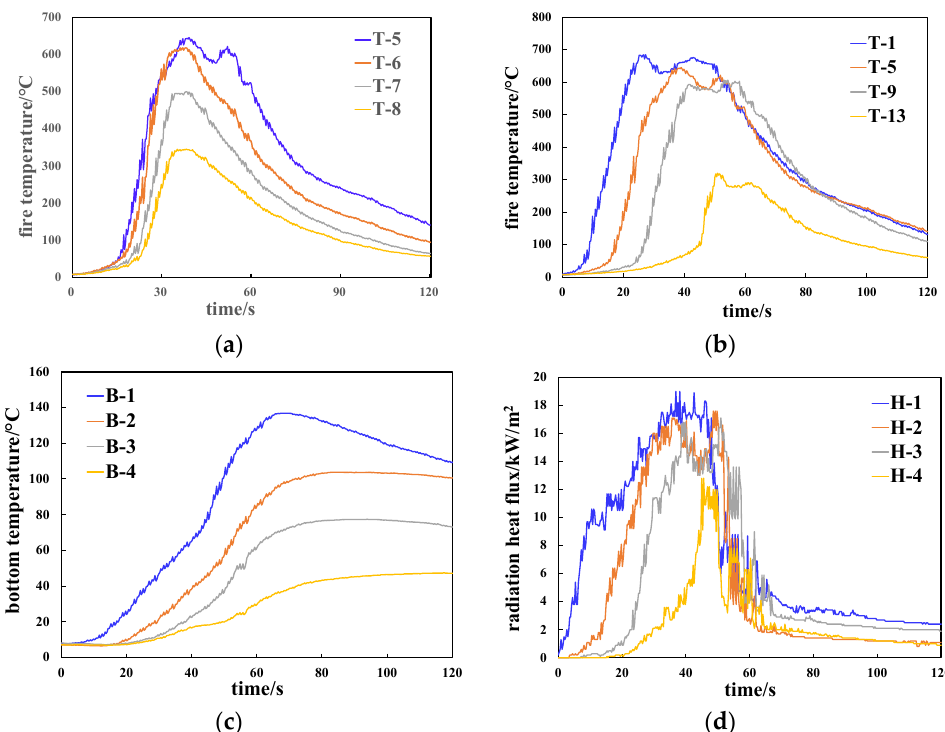
Figure 6. Various physical characteristics measured by thermocouples and heat flow meters in the burning process. ( a ) Flame temperatures at different heights; ( b ) flame temperatures at different distances; ( c ) bottom temperature at different distances; ( d ) feedback radiation transmission at different distances.